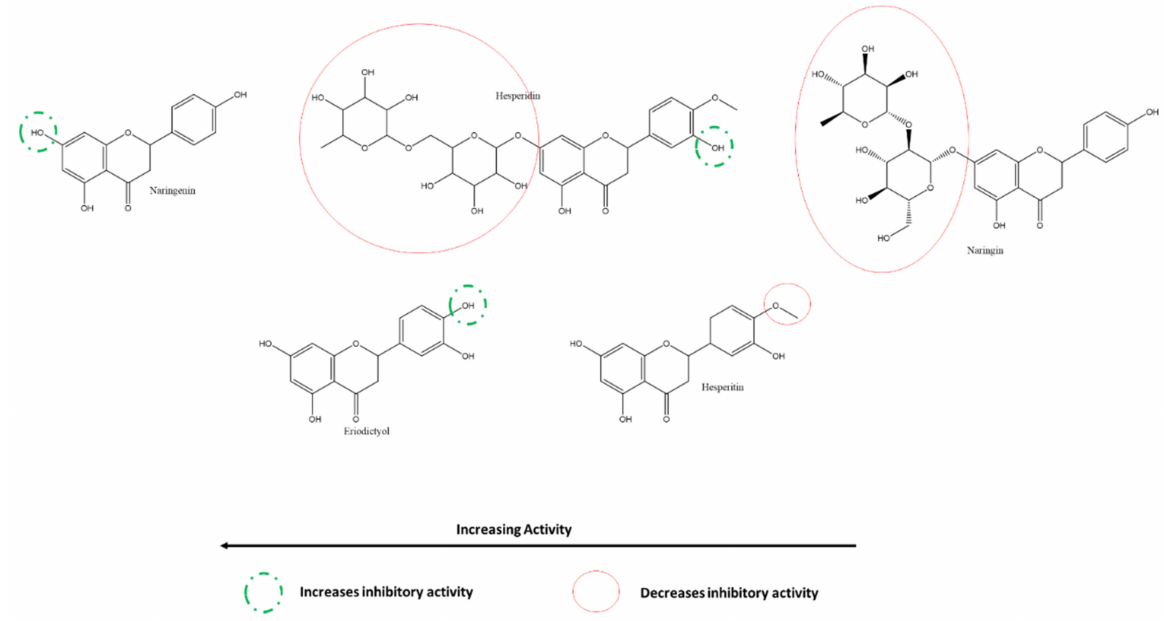
Figure 14. Structure–activity relationships of various flavanones against SARS-CoV-2 3CLpro, adapted from the experiments of [117,118] using in vitro FRET assays. Substitutions and groups that result in an increase/decrease in inhibitory activities are shown in red and green,